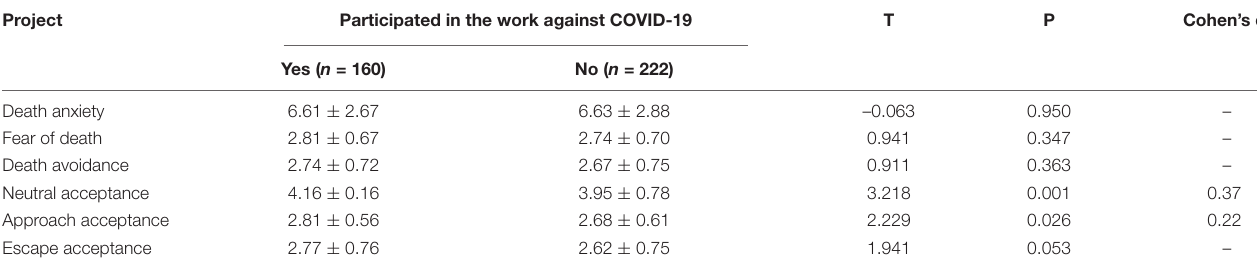
TABLE 6 | Results of death attitude and anxiety in participated in the work against COVID-19. Project Participated in the work against COVID-19